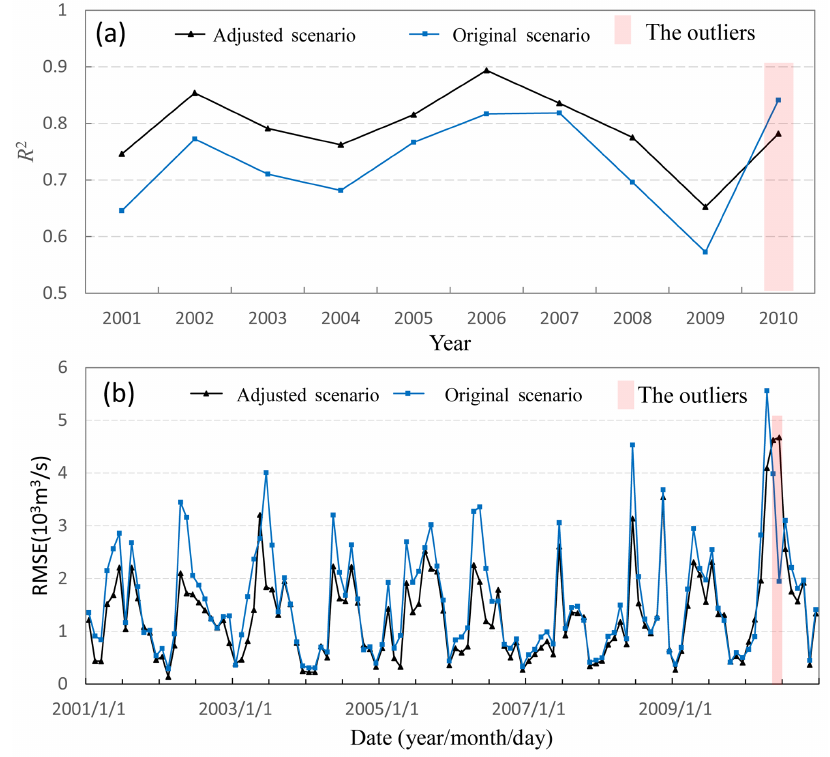
Figure 6. Comparison of the simulated stream flow results at Hukou, in the adjusted scenario and original scenario. The outlier is the data which may be affected by the dike burst in